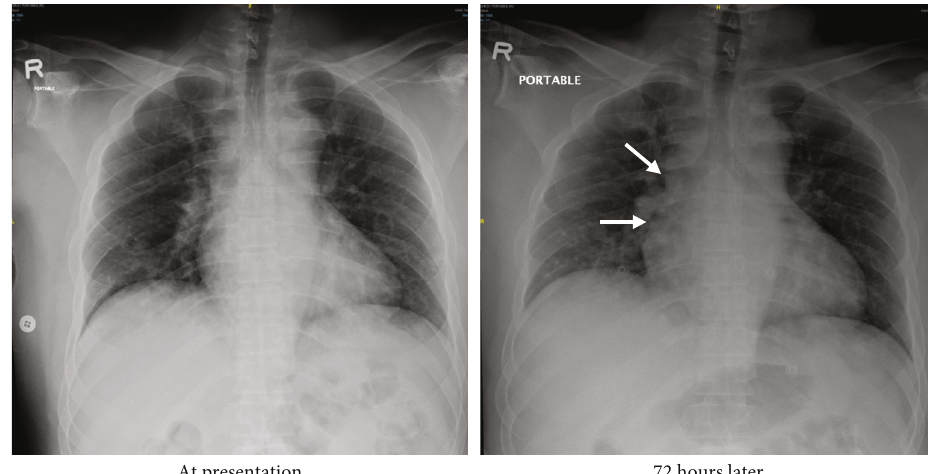
Figure 1: Chest radiograph on the day of onset of symptoms showing no evidence of pneumonia nor any radiological fi ndings of acute respiratory distress syndrome (ARDS). At 72 hours: ground-glass opaci fi cation and alveolar consolidation were seen in the middle of right lobe